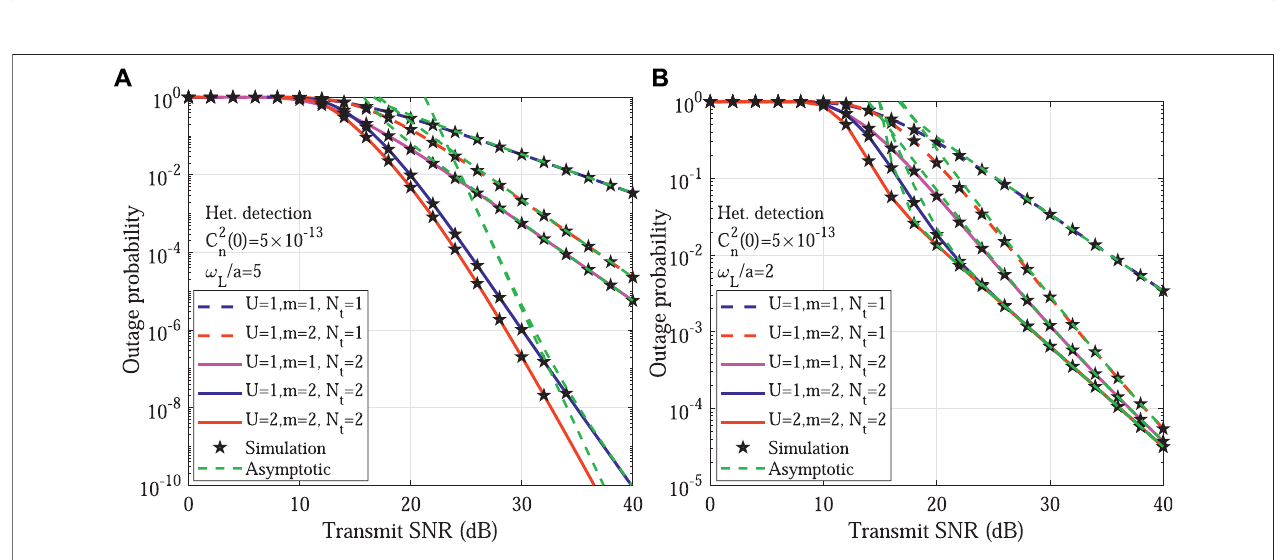
FIGURE 4 | Analytical, simulation, and asymptotic results of overall outage probability against transmit SNR for (A) Moderate pointing error and (B) Severe pointing error.